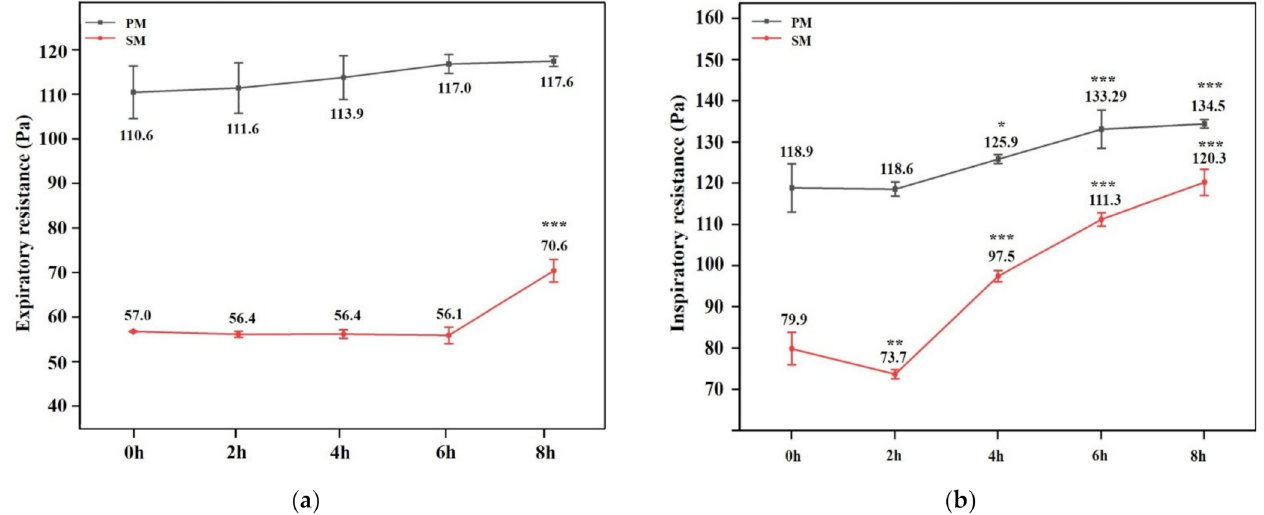
Figure 8. Results of experiments on expiratory and inspiratory resistance. ( a ) expiratory resistance; ( b ) inspiratory resistance. *: p value < 0.05, **: p value < 0.01, ***: p value <